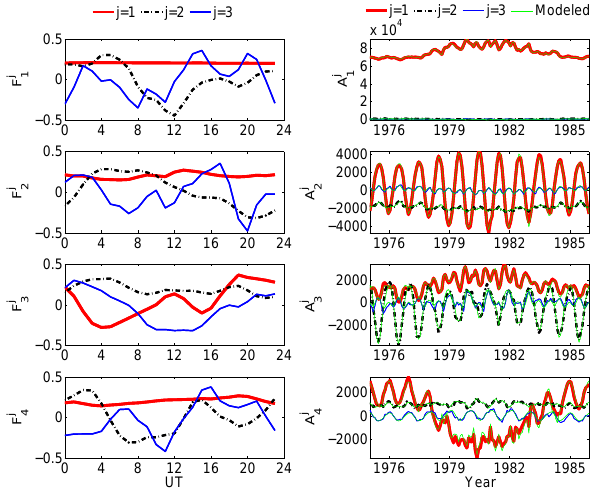
Fig. 5. Distribution of the base functions ( F j their corresponding coefficients ( A j with the second layer EOF decomposition of hm F2.